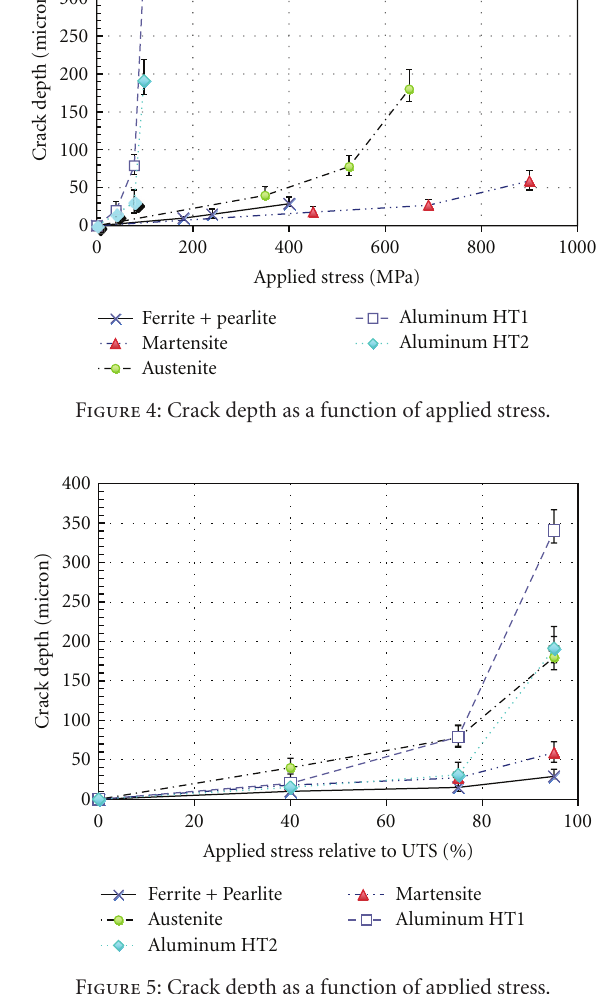
Similarly, the results are also useful for practical engineers working in the field. The mechanism of SCC of the austenite and aluminum was found to be dominated by the corrosion tunnel model, while SCC of the other microstructures occurred by film